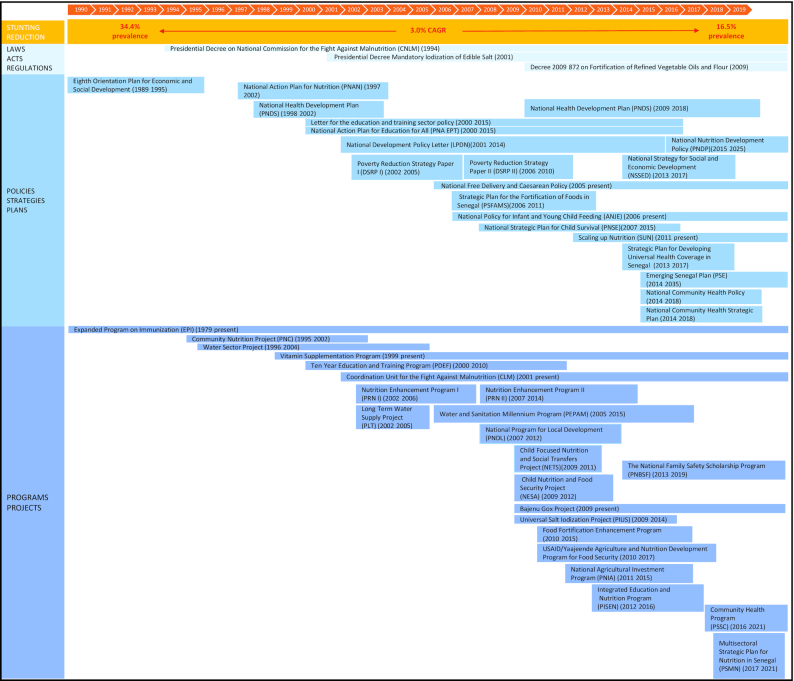
Overview of laws, policies, programs, and enablers between 1990 and 2019 in Senegal.